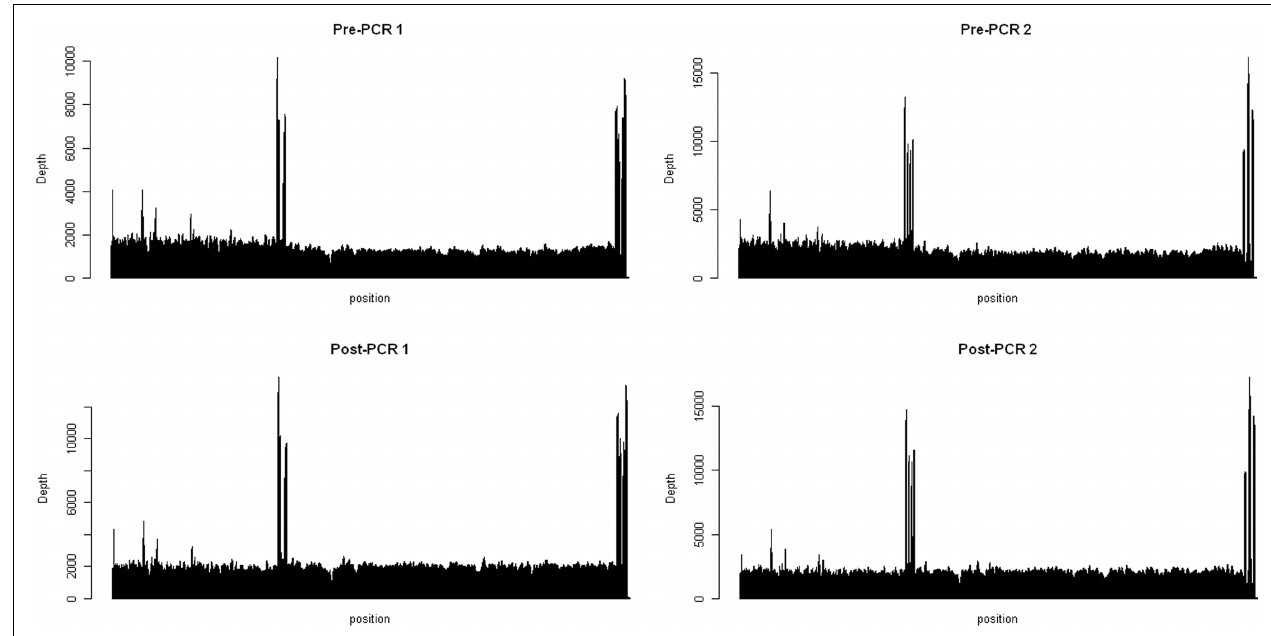
FIGURE 1 | Coverage maps for the pooled mtDNA before amplification (Top) and the pooled fragment 1 and 2 (Bottom). The x axis represents the